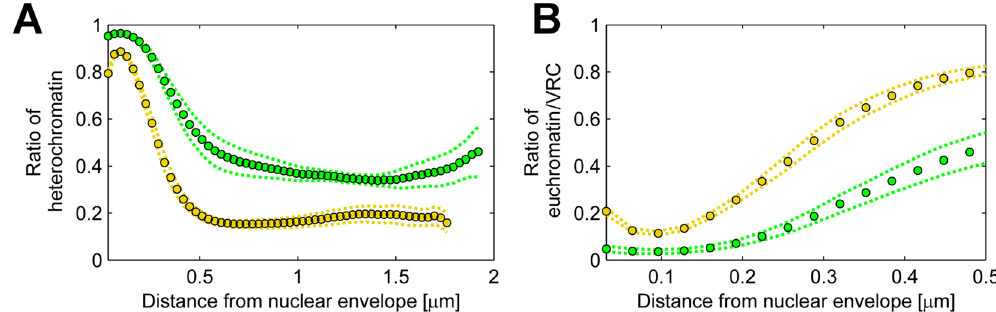
Figure 4. Relative distribution of cellular heterochromatin and viral VRC. ( A ) The relative amount of heterochromatin in infected (yellow) and non-infected (green) cells as a function of distance from the NE. ( B ) The relative amount of euchromatin/VRC in infected (yellow) and non-infected (green) cells at increasing distances from the NE. Dotted error lines represent the mean ±